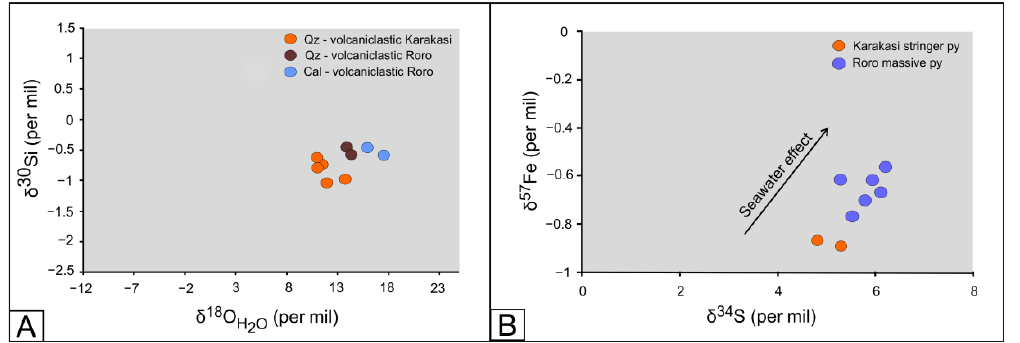
Figure 4. Stable isotope binary diagrams of pyrite and gangue phases from Roro and Karakasi VMS. ( A ) δ 18 O– δ 30 Si binary diagram of gangue quartz (Qz) and calcite (Cal) from the footwall volcaniclastic rocks from Roro and Karakasi VMS. ( B ) δ 34 S– δ 57 Fe binary diagram of massive (Roro) and stringer (Karakasi) pyrite from Ermioni VMS (with modifications after [27]).